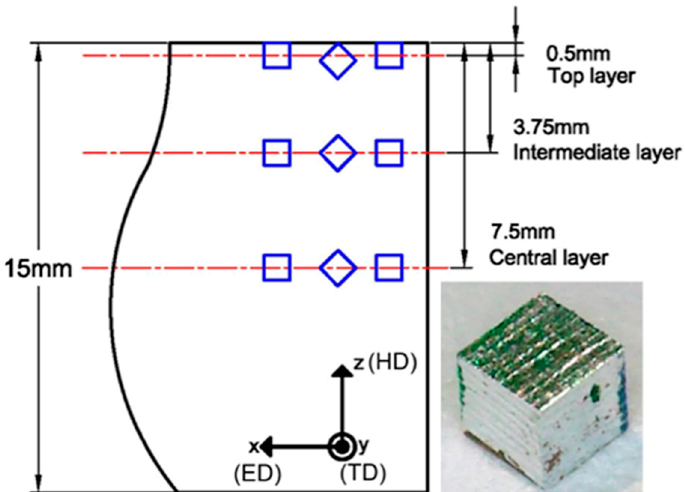
Figure 2. Position and orientation of small-cube specimens for compression test.